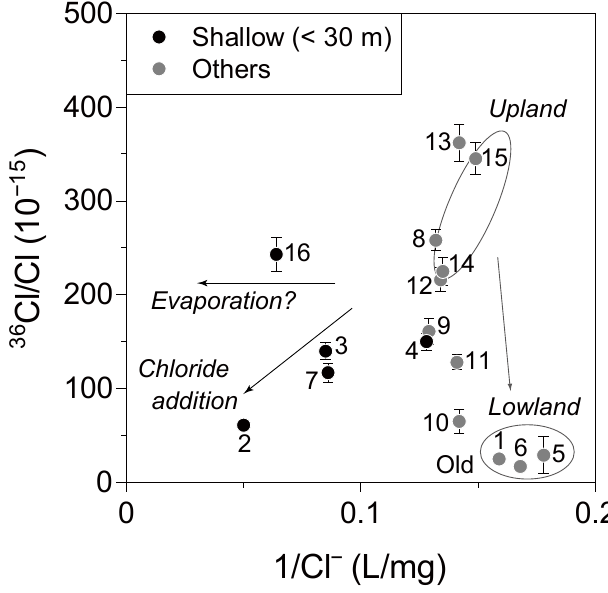
Figure 9. 36 Cl/Cl values for groundwater plotted against the reciprocal of Cl −